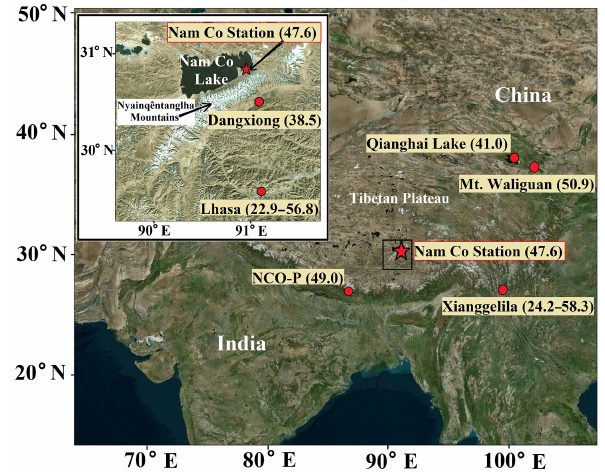
Figure 1. Geographical location of Nam Co Station and other sites in the Tibetan Plateau. Values in parentheses refer to the average or range of surface ozone in parts per billion as obtained from Cristo- fanelli et al. (2010), Lin et al. (2015), Shen et al. (2014), Xu et al. (2011), Ma et al. (2014), and Ran et al.